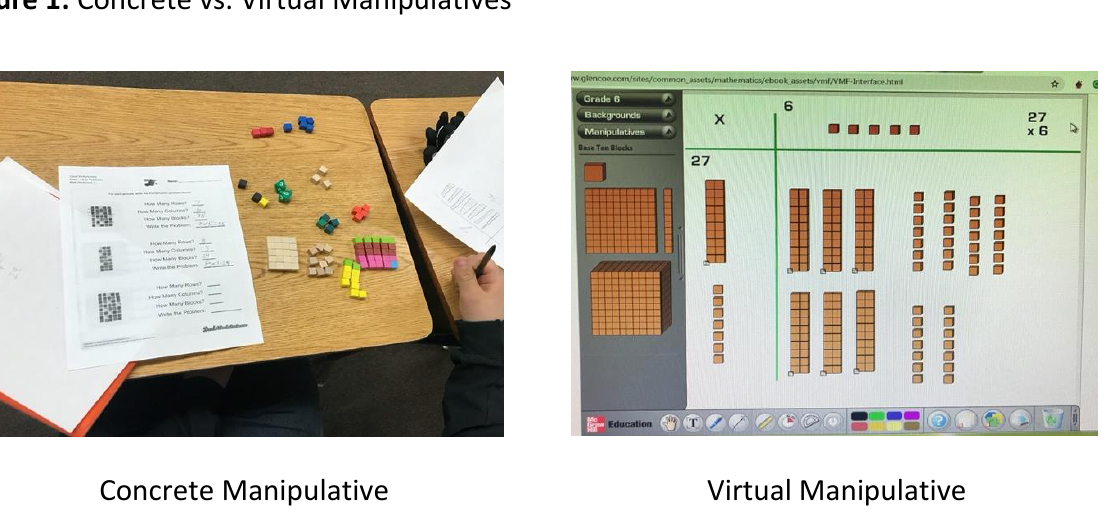
Figure 1: Concrete vs. Virtual Manipulatives